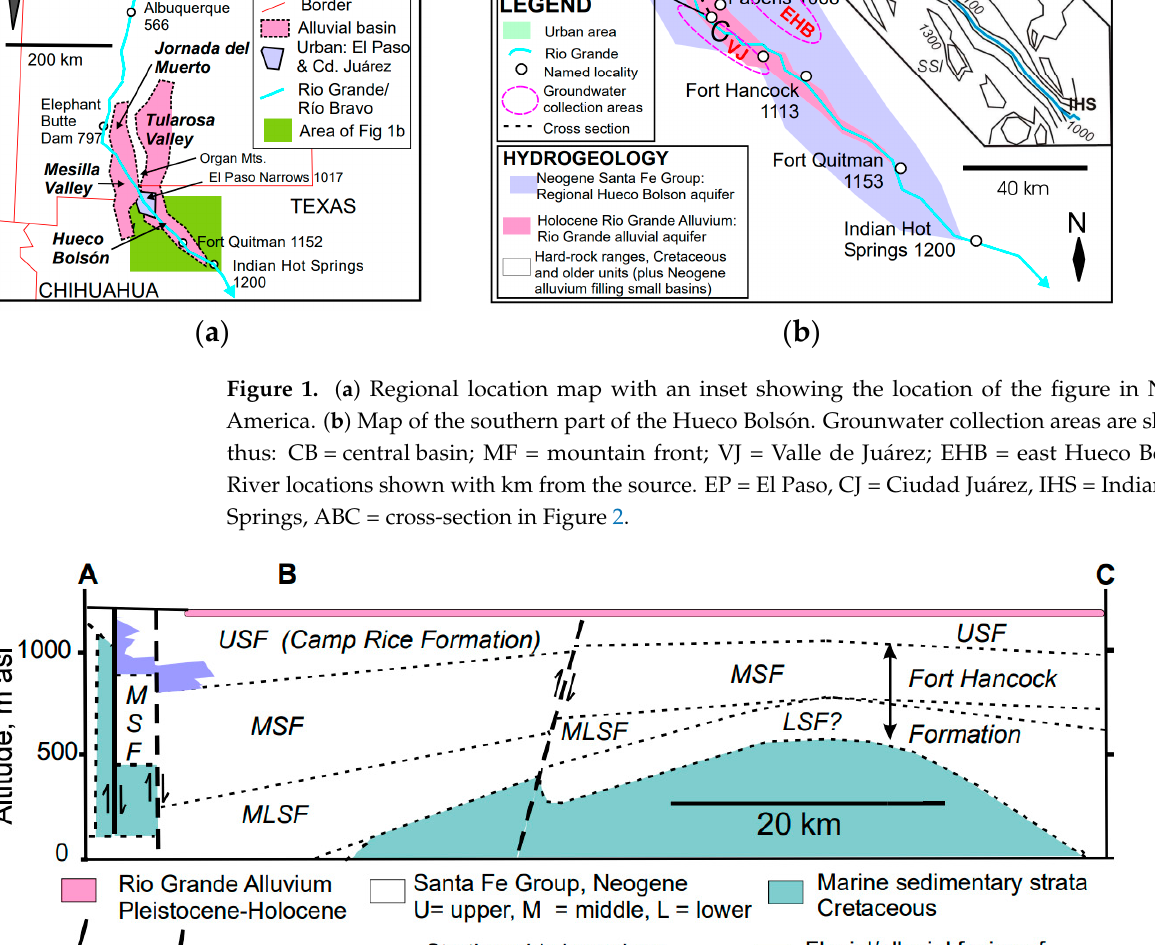
Figure 2. Geologic cross-section from Sierra de Juárez to Fabens (see Figure 1). USF = upper Santa Fe Group; MSF = middle Santa Fe Group; LSF = lower Santa Fe Group; MLSF = middle or lower Santa Fe Group. A, B and C are points shown in Figure 1.